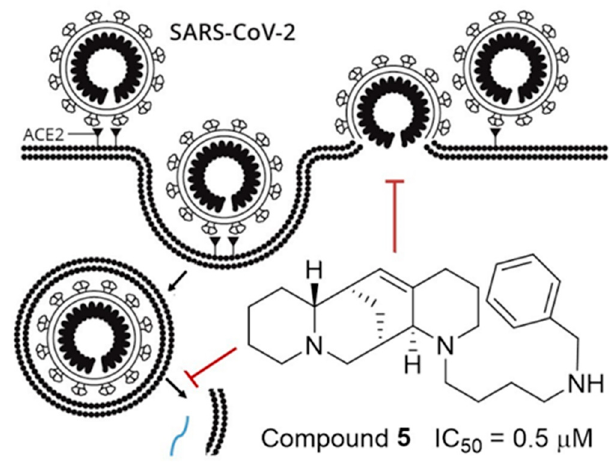
Figure 3. Model for inhibition of SARS-Cov-2 entry by Compound 5 .